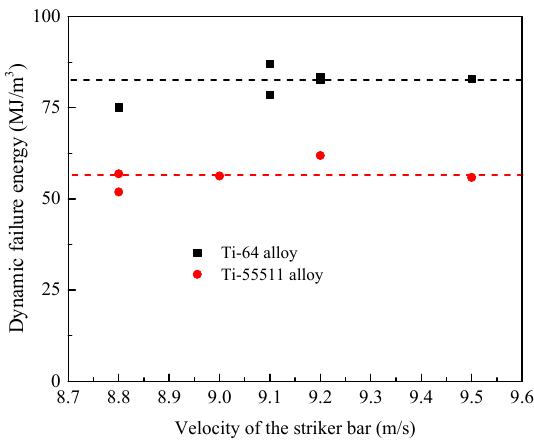
Figure 12. Plot of the dynamic failure (mechanical) energy of Ti-64 and Ti-55511 alloy as a function of the velocity of the striker bar.